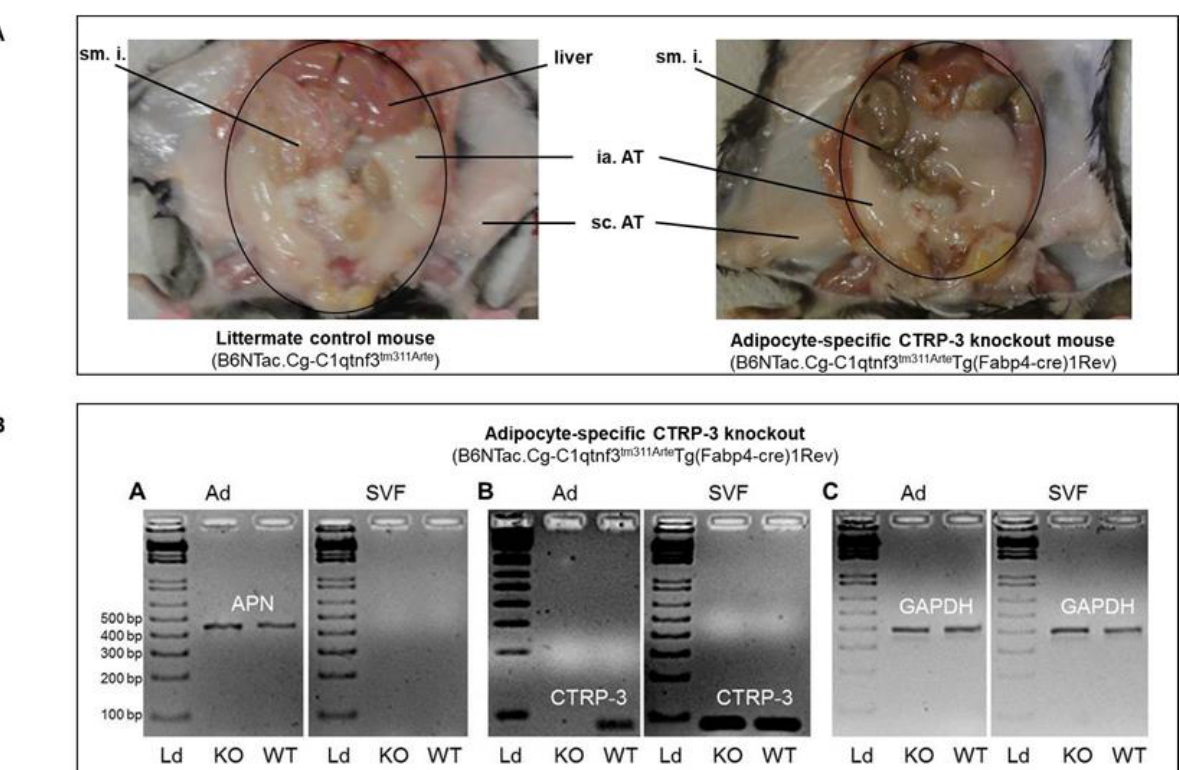
Figure 1. Generation of a novel adipocyte CTRP-3 knockout mouse model by using the transgenic Cre/loxP system with the Cre recombinase under the control of the aP2 promoter. Panel ( A ): The macroscopic phenotype (abdominal situs) of littermate control mice and adipocyte CTRP-3 knockout mice was identical under basal conditions. sm.i., small intestine; ia. AT, intra-abdominal adipose tissue (yellow-white); sc. AT, subcutaneous adipose tissue (bright white). Panel ( B ): Gene expression in adipocytes and in stroma-vascular cells of littermate control mice (WT) and CTRP-3 KO mice. The adiponectin gene is expressed in adipocytes of control and KO mice but not in the stroma-vascular cell fraction (SVF) (B-A). The CTRP-3 gene is specifically knocked out in adipocytes of KO mice but not in wildtype mice or in the SVF (B-B). The expression of the housekeeping gene GAPDH was not altered (B-C). Mature adipocytes and cells of the stroma-vascular fraction were isolated from adipose tissue of CTRP-3 KO and control mice. After separation of cell fractions and isolation of mRNA, C1qtnf3 , APN (adiponectin, as an adipocyte-specific marker), and GAPDH (as a housekeeping gene) were amplified by real-time PCR. Amplicons were visualized and analyzed by agarose gel electrophoresis. Ad, adipocyte; APN , adiponectin; GAPDH , glyceraldehyde-3-phosphate dehydrogenase; Ld, nucleic acid standard (DNA ladder); KO, adipocyte-specific CTRP-3 knockout mice (B6NTac.Cg- C1qtnf3 tm311Arte Tg(Fabp4-cre)1Rev); WT, littermate control animals (B6NTac.Cg- C1qtnf3 tm311Arte ); SVF, stroma-vascular cell